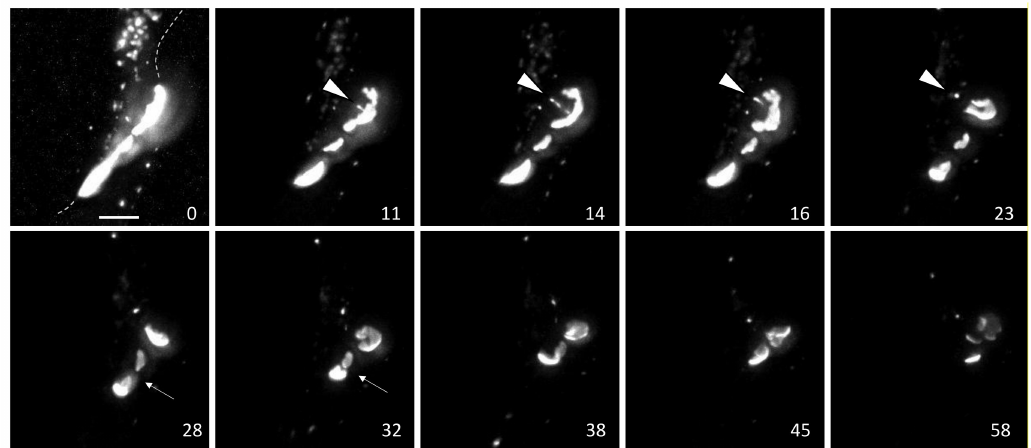
Figure 1. LLSM images from movie of cells expressing Cx43 mEmerald. Time in minutes is indicated in the lower right of each panel and the bar is 5 µ m. See movie in Supplementary